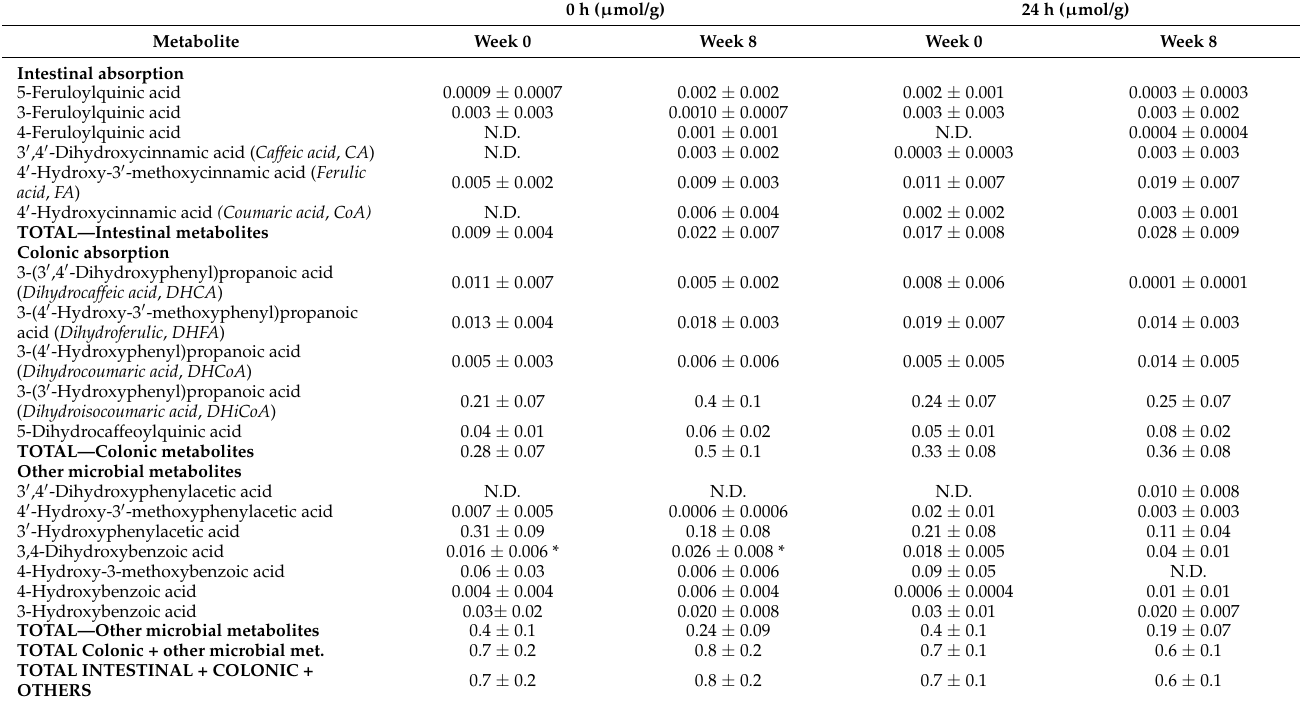
Table 3. Amount of fecal metabolites excreted at 0 h and 24 h after consumption of the GCPE nutraceutical at the baseline (week 0) and the end of the intervention (week 8). 0 h ( µ